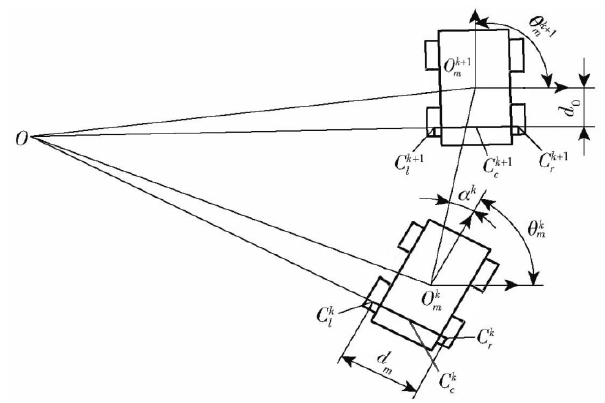
Figure 2. Motion analysis of triangular crawler chassis.